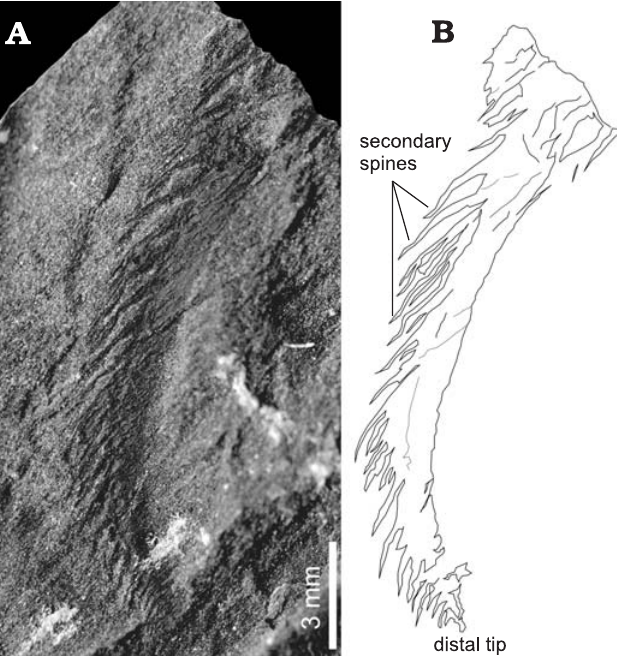
Fig. 1. Marellomorph arthropod Dyrnwynia conollyi gen. et sp. nov. from the Llanfallteg Formation, Didymograptus artus Biozone, Darriwilian, Or- dovician; Pembrokeshire, Wales, UK. Holotype (NMW 2016.7G.83), iso- lated mediolateral spine. A . Photograph. B . Camera lucida